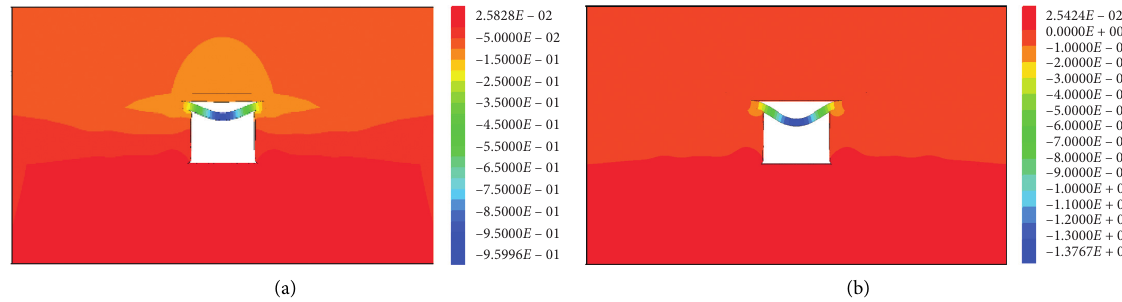
Figure 10: Roof sag of different rock-coal interfacial cohesion: (a) 0.1 MPa and (b) 2 MPa.